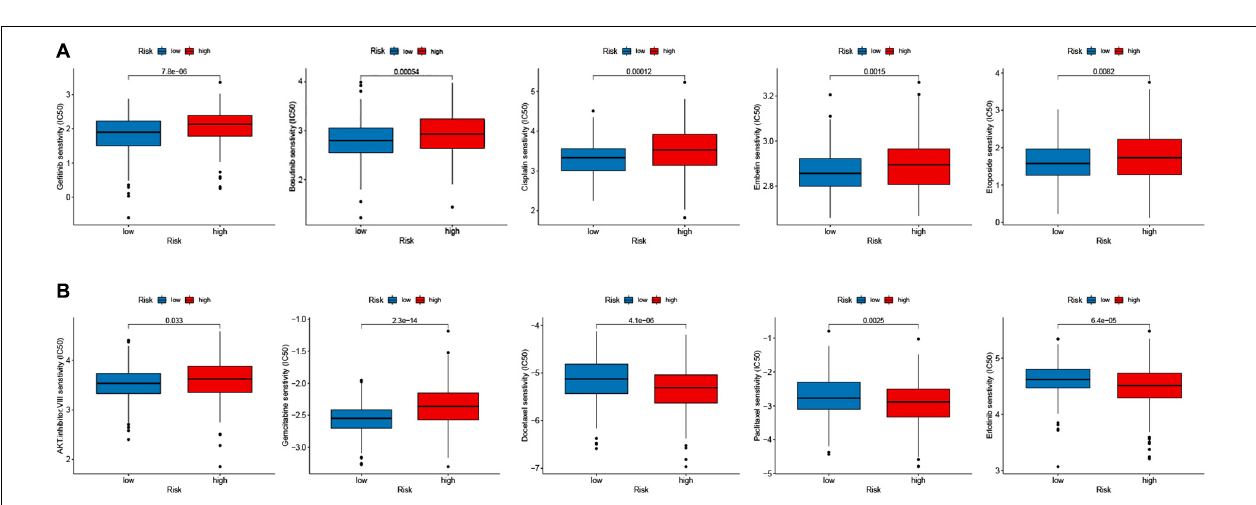
FIGURE 6 | Relationships between the signature and drug susceptibility. (A) Gefitinib, Bosutinib, Cisplatin, Embelin, and Etoposide. (B) AKT inhibitor VIII, Gemcitabine, Docetaxel, Paclitaxel, and Erlotinib.